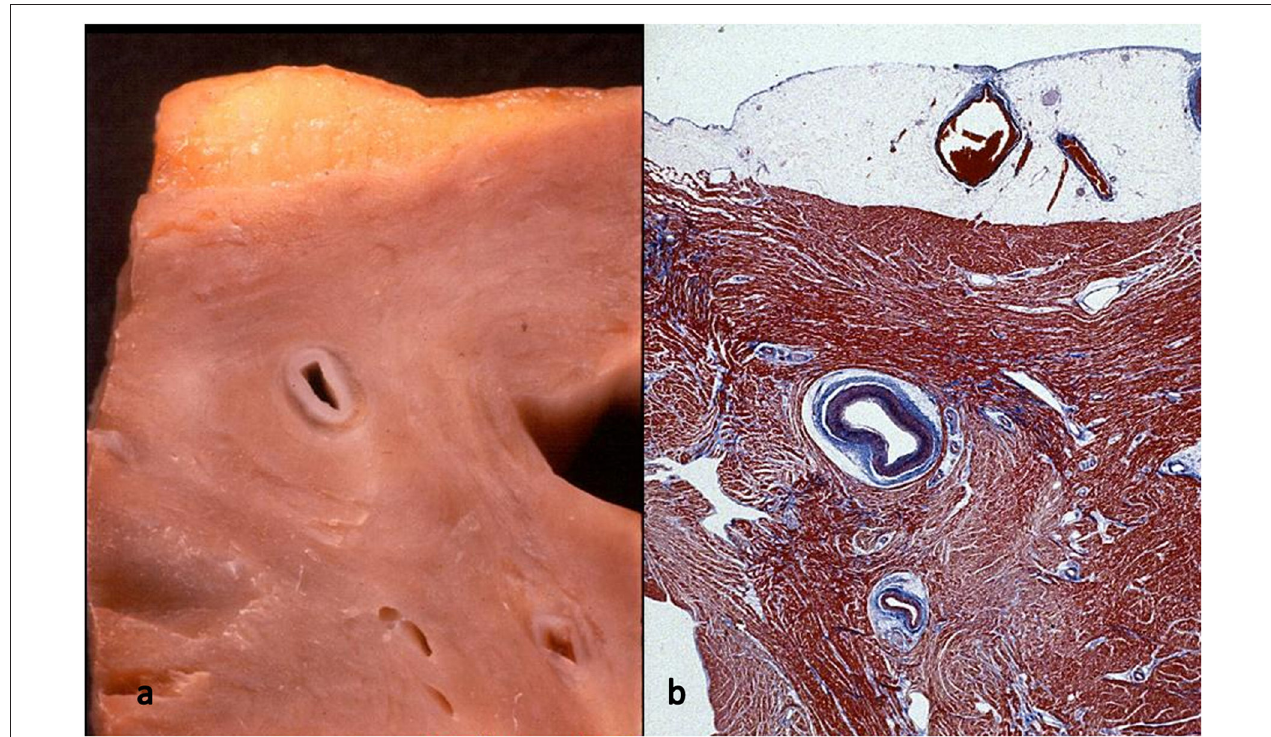
FIGURE 10 | Myocardial bridge with deep intramural course: the coronary segment is completely surrounded by a myocardial sleeve. Gross (a) and histological views (b) . Azan Mallory stain.